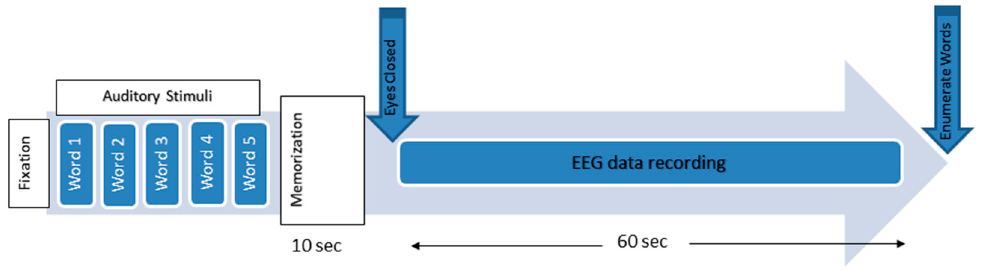
Figure 2. The working memory experimental paradigm [59].